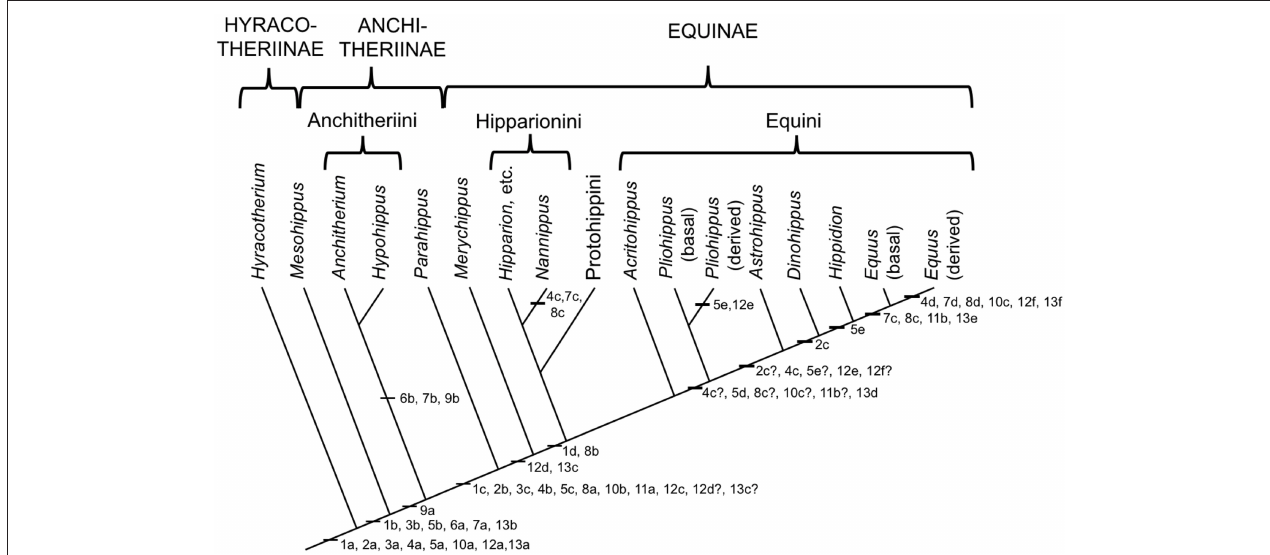
FIGURE 2 | Phylogeny of selected genera (discussed in this paper) within the Equidae based on the phylogeny in (Maguire and Stigall, 2009). Original drawing by CMJ, final figure rendered by James G. Napoli. The numbers on the phylogeny refer to the anatomical characters listed below: note that the “basal” characters are for reference for the generalized condition, and are not necessarily specific to the Equidae. Miohippus (not shown) is crownward of Mesohippus and basal to the Anchitheriini. Characters at the level of Parahippus probably also apply to the other stem equine anchitheres (i.e., crownward of the Anchitheriini) Archaeohippus and Desmatippus (both basal to Parahippus ). Anchitherium is an Old World taxon, and North American early Miocene equids originally called Anchitherium should be referred to Kalobatippus ( MacFadden, 1992, 1998). Nannippus is singled out because of its unique morphology, and is not the sister taxon to the other hipparionins. Within the Equini, Parapliohippus, Heteropliohippus , and Onohippidium (which may not be distinct from Hippidion ) are not shown. 1. Foot posture and foot pad: (a) subunguligrade, foot pad extensive; (b) subunguligrade, foot pad slightly reduced; (c) unguligrade, foot pad converted to digital cushion (3rd phalanges contained within enlarged hoof); (d) Digital cushion reduced slightly. 2. Phalangeal proportions of third (central) digit: (a) 1st phalanx short (length < 2X width), 3rd phalanx longer than 2nd, inclination to ground < 26 ◦ ; (b) 1st phalanx elongated (length > 2X width), 3rd phalanx shorter than second, inclination > 26 ◦ , < 35 ◦ ; (c) inclination of third phalanx > 40 ◦ 3. Third (central) metapodial shaft: (a) similar size to second and fourth metapodials (slightly longer and broader), cross-sectional area oval or elliptical; (b) elongated relative to proximal limb bones, and proportionally longer and broader than second and fourth metapodials; (c) further increased in proportional size, cross-sectional area more circular. 4. Third (central) metapodial distal articulatory surface: (a) narrower in width than metapodial shaft above distal tubercules, sagittal ridge confined to volar surface; articulatory curvature < 180 ◦ , flexor (volar) surface with greater curvature than extensor (dorsal) surface; (b) sagittal ridge more prominent, encroaches onto dorsal surface, received by groove in first phalanx; articulatory curvature at least 180 ◦ , extensor surface with greater curvature than flexor surface, transverse ridge at point of change of curvature (documented for “ Merychippus ,” presumed to occur in Parahippus ); (c) Broader in width than metapodial shaft above distal tubercules, sagittal ridge still more prominent, further encroaching onto dorsal surface; (d) sagittal ridge extremely prominent, fully extended onto dorsal surface. 5. Other metapodials and associated digits: (a) complete metapodial 5 and digit 5 retained in manus, metapodial 1 and digit 1 lost; metapodials 2 and 4 large, not bound to central metapodial, associated digits likely contacted ground during regular locomotion; (b) metapodial 5 and digit 5 greatly reduced or lost, metapodials 2 and 4 more tightly bound to central metapodial; (c) shafts of metapodials 2 and 4 reduced, tightly bound to central metapodial by ligaments, associated digits smaller, no longer contact the ground during regular locomotion, but may do so during more extreme performance; (d) sagittal ridge/groove for articulation of 1st phalanges on metapodials 2 and 4 now very faint or lost entirely; shafts of metapodials 2 and 4 further reduced in width, associated digits further reduced in size; (e) shafts of metapodial 2 and 4 confined to proximal two thirds of central metapodial (i.e., transformed to “splint” bones), associated digits lost. 6. Scars for cruciate sesamoid ligaments (proximal volar surface of 1st phalanx): (a) present; (b) enlarged. 7. Scar for central sesamoidean ligament (mid volar surface of 1st phalanx of 3rd digit): (a) present; (b) enlarged; (c) reduced; (d) lost/merged with V-scar for oblique ligaments. 8. Scars for oblique sesamoid ligaments (proximal to mid volar surface of 1st phalanx of 3rd digit): (a) present, small, round, extend no more than 30% down phalanx; (b) enlarged, forming incipient V-scar, extend further down phalanx ( < 50% of bone); (c) elongated, extend > 50% down phalanx; (d) merge to form more distinct V-scar, extend 66% down phalanx. 9. Scars for straight sesamoid ligament (proximal volar surface of 2nd phalanx of 3rd digit): (a) present; (b) enlarged. 10. Suspensory ligament: (a) probably fully muscular ( = interosseous muscle of 3rd metapodial and digit); (b) at least partially tendinous; (c) fully tendinous (evidenced by loss of volar gulley on third metapodials). 11. Size of proximal sesamoid bones of 3rd digit: (a) increase in size to support the suspensory apparatus; (b) further enlarged. 12. Tarsus: (a) astragalus articulates predominantly with navicular, distal articulation rounded, ridges of trochlea directed anteriolaterally (angle with sagittal plane 14–20 ◦ ), considerable intertarsal movement possible, relatively long astragalar neck; (b) astragalar neck shorter; (c) more restrictive tibia–astragalar articulation, distal articulation of astragulus with navicular wider and flatter; (d) ridges of astragalar trochleae higher, restricting motion to parasagittal plane, intertarsal movement more restricted by ligaments; (e) width of astragalus greater than length; (f) ridges of astragalar trochlea narrower and directed more anteriorly (angle with sagittal plane 10–15 ◦ ), reduced lateral swing of foot, little or no intratarsal movement possible. 13. Knee joint: (a) angle at knee joint ∼ 102 ◦ , large and rugose area on tibia for attachment of semitendinosus muscle for limb retraction–reflects more flexed knee joint and tibial rotation on limb retraction; (b) angle at knee joint ∼ 108 ◦ ; (c) angle at knee joint ∼ 131 ◦ ; (d) area of attachment of semitendinosus of moderate size; (e) angle at knee joint ∼ 140 ◦ ; (f) Area of attachment of semitendinosus weak, angle at knee joint ∼ 150 ◦ .